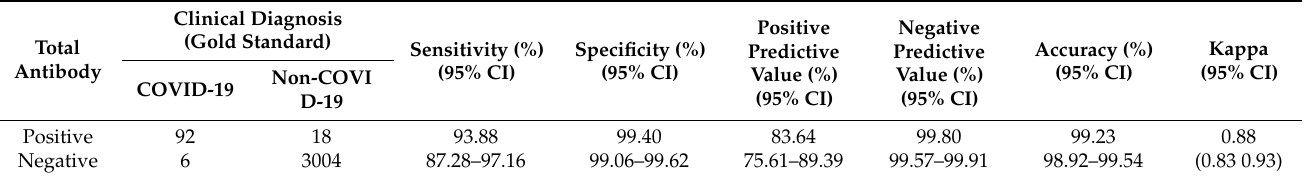
Figure 1. Diagnostic performance of the total antibody test for COVID-19. ( A ) Comparison of the titer of total antibodies in COVID-19 and non-COVID-19 patients; ( B ) ROC showing sensitivity as a function of specificity for the use of total antibodies for COVID-19 diagnosis. COI, the cutoff index. Table 2. Diagnostic performance of the first total antibody for COVID-19 based on clinical diagnosis.